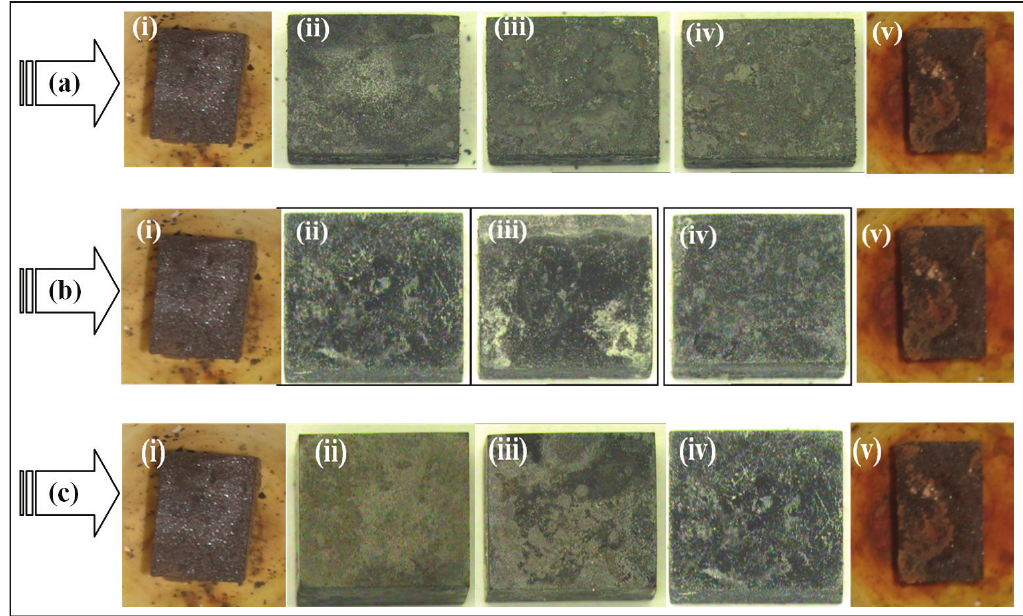
Figure 7. Macrographs of the hot corroded samples of GTA weldments employing (a) ER309L (b) ERNiCu-7 and (c) ERNiCrFe-3 filler wires representing the zones (i) Parent metal - AOSO 304 (ii) HAZ - AOSO 304 (iii) Weld (iv) HAZ - Monel 400 (v) Parent metal - Monel